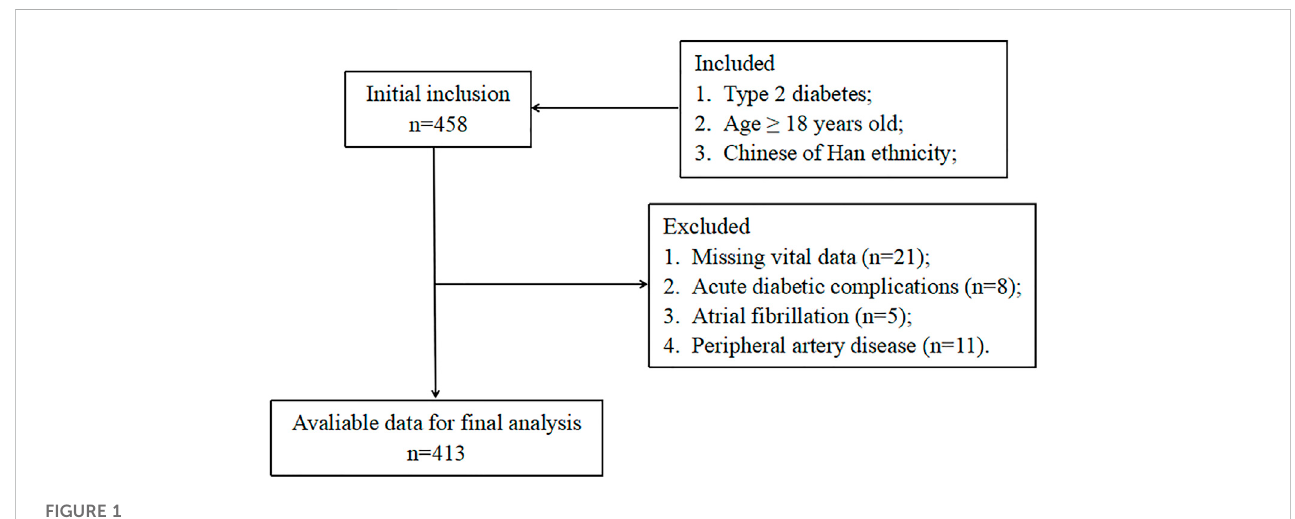
FIGURE 1 The study fl